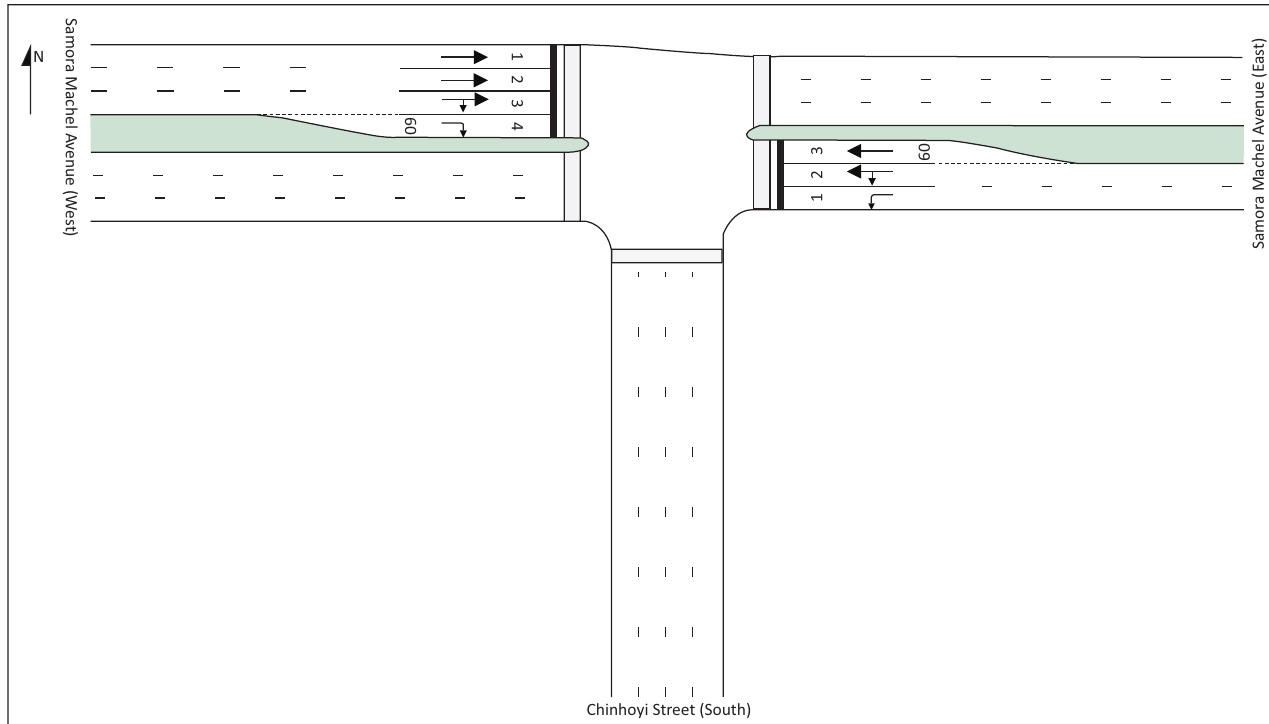
FIGURE 5: Geometrical configuration of surveyed